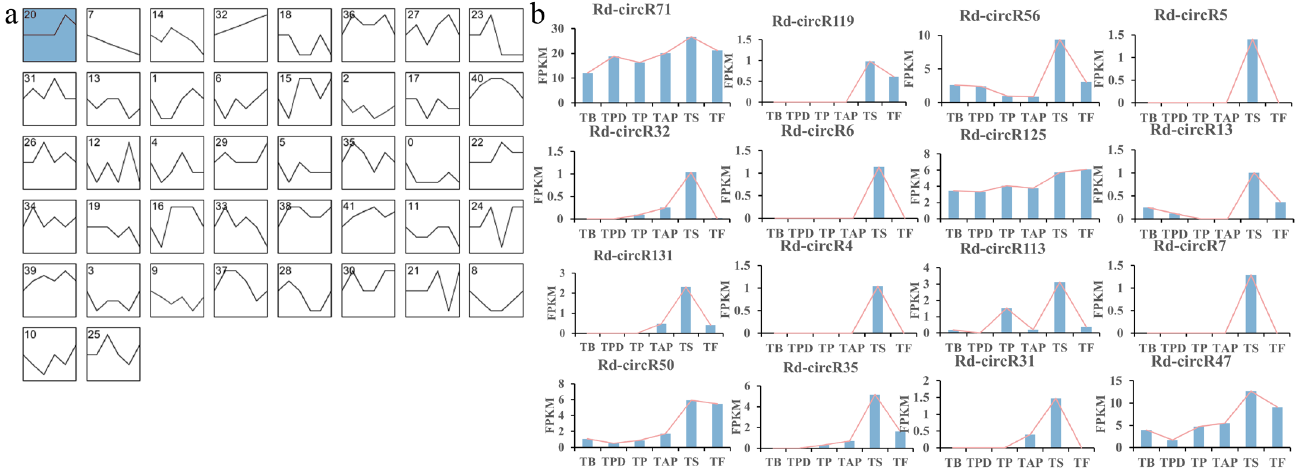
Figure 4. Patterns of circRNA expression in six stages inferred by STEM analysis: ( a ) 42 candidate profiles were obtained via STEM analysis. Only one colored profile is significant profile ( p ≤ 0.05); ( b ) 16 circRNAs were clustered into this significant expression profile. TB: the time of bud stage; TPD: pollen dehiscence stage; TP: pollination stage; TAP: after pollina-tion stage; TS: senescence stage; and TF: fading stage.